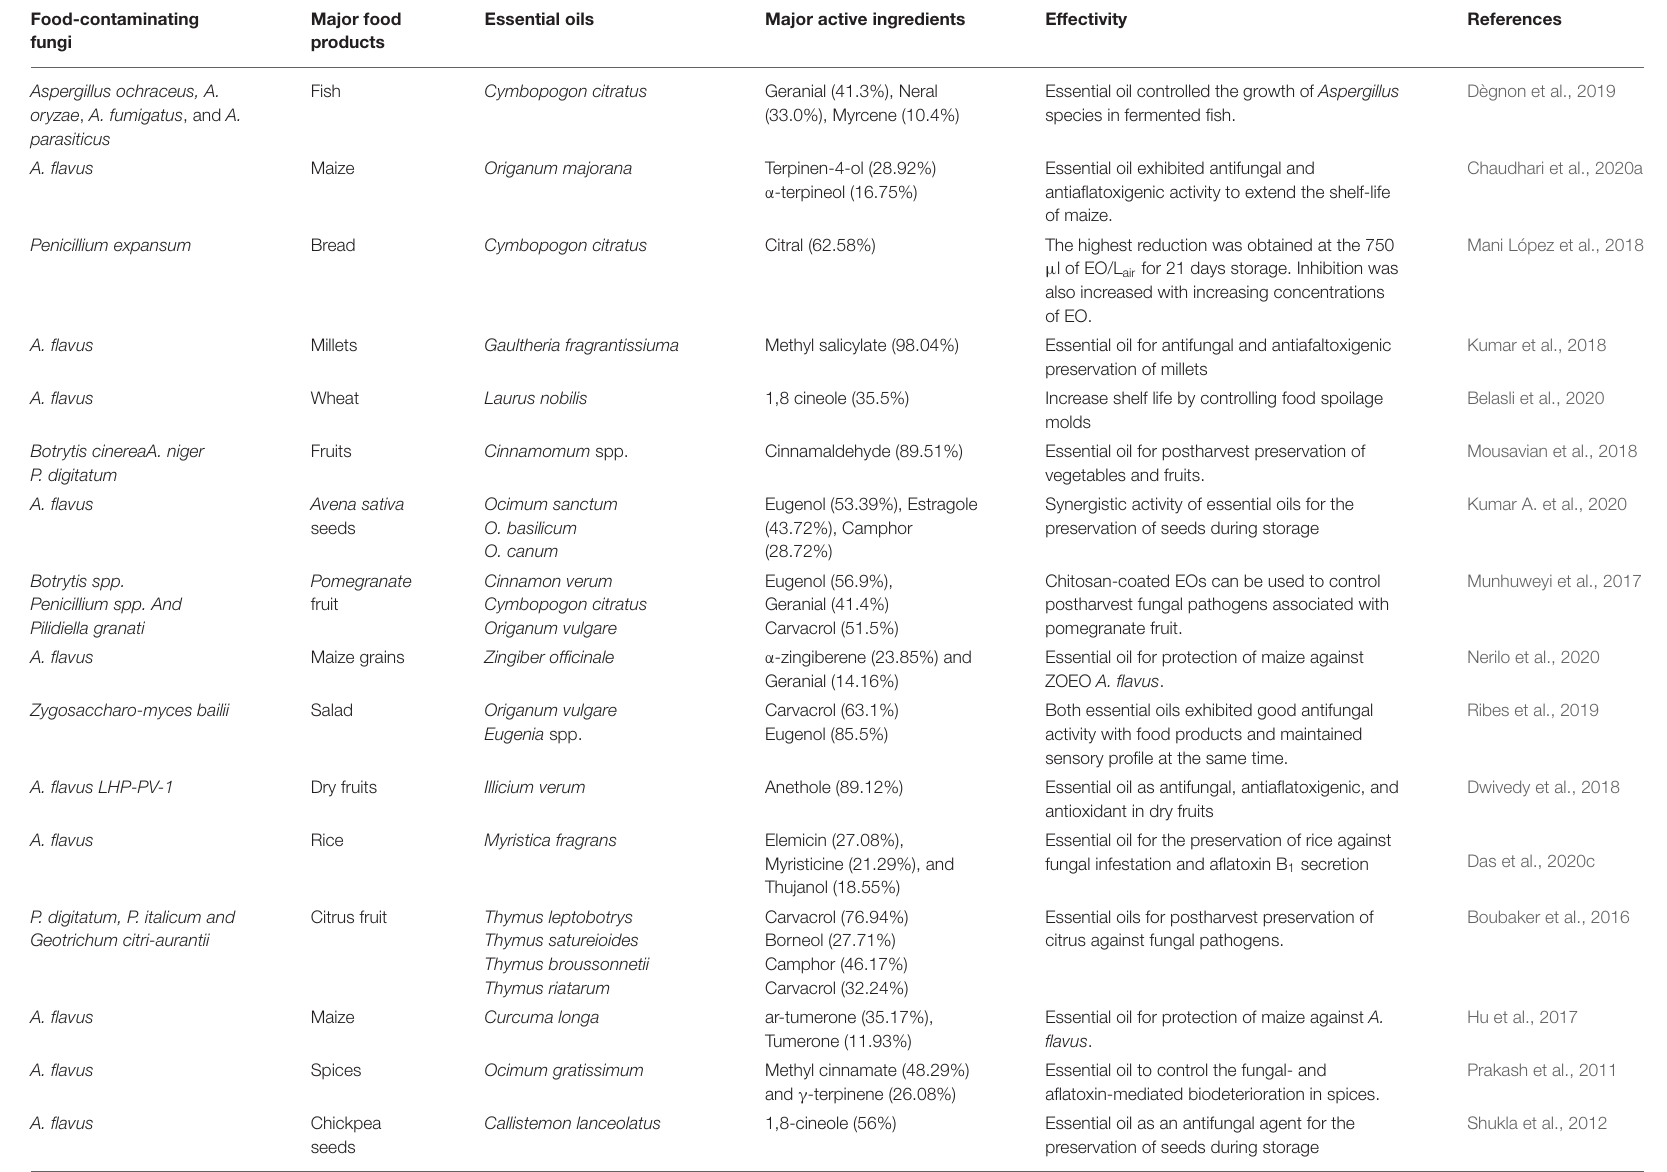
TABLE 3 | Essential oils and their active components against different food contaminating